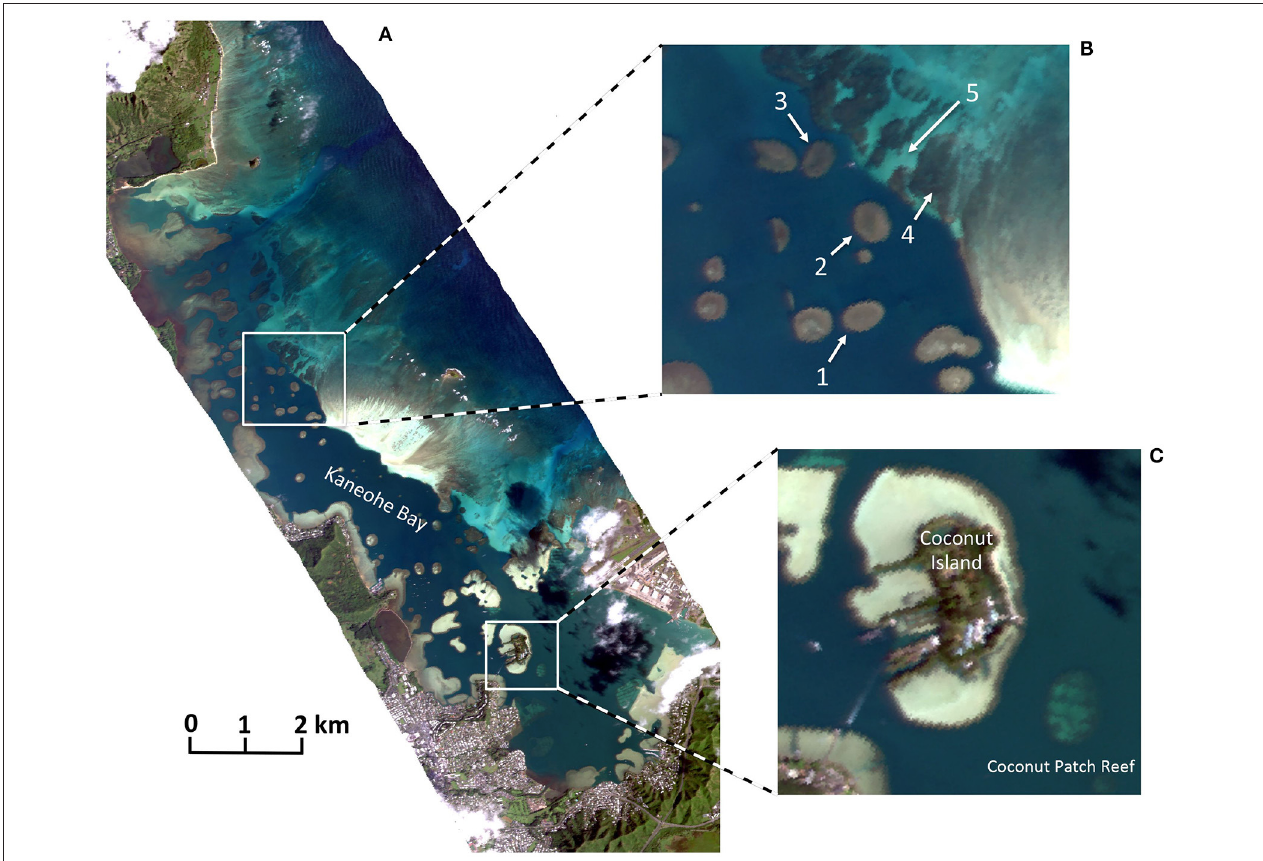
FIGURE 4 | (A) Hyperspectral image of Kane’ohe Bay collected on 3 March 2017 at 19:00 GMT, 09:00 local time, using the Jet Propulsion Laboratory Airborne Visible Near Infrared Imaging Spectrometer - Classic (AVIRIS) deployed on the NASA ER-2 aircraft at an altitude of approximately 19.8 km. The ground sampling distance was approximately 7m. (B) Reef areas examined for spectral reflectance. (C) The coconut patch reef, where ASV surveys were